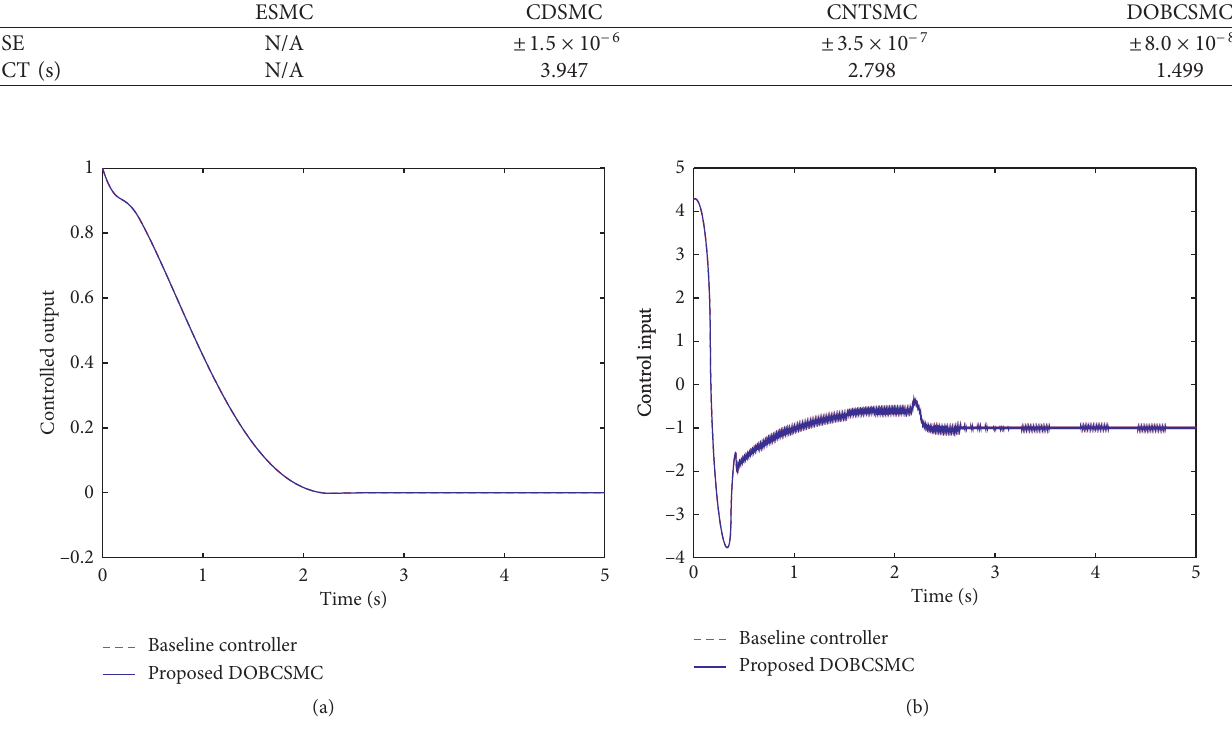
Figure 5: Nominal performance recovery with the DOBCSMC (Scenario